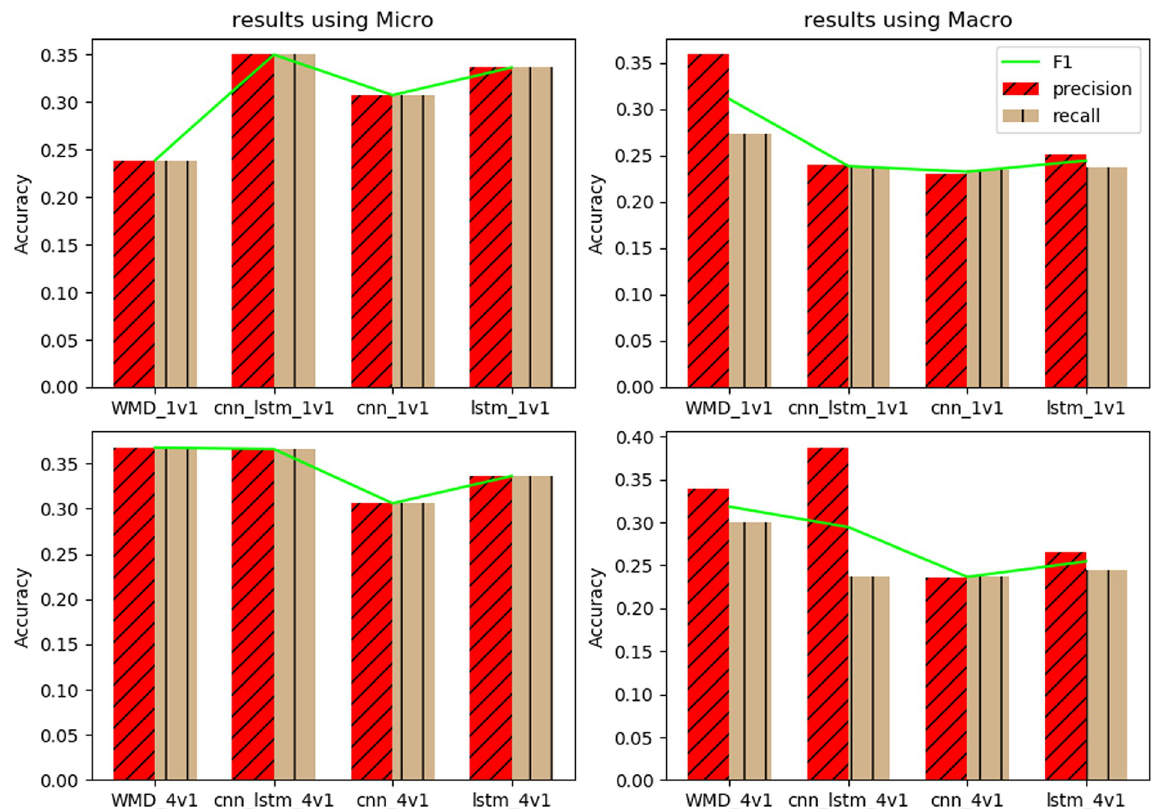
Fig 7. Classification results on WMD and the three